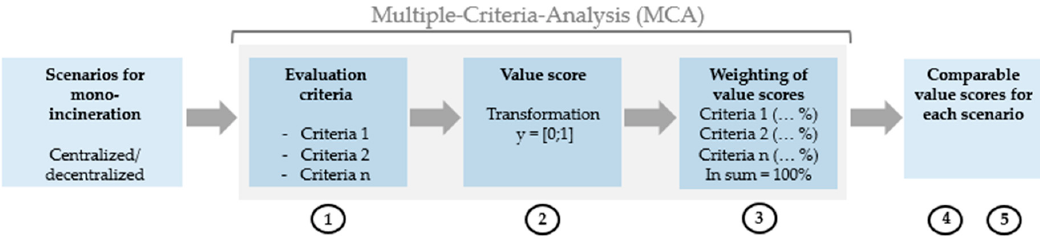
Figure 4. Procedural steps for evaluation of scenarios via a multiple criteria analysis (MCA). 1. Quantify all values for each evaluation criteria in each scenario. 2. Transform to value scores, y = [0; 1]. 3. Weigh the values. 4. Summarize the value scores in each scenario. 5. Compare and interpret the results. Adapted after Bättig et al.